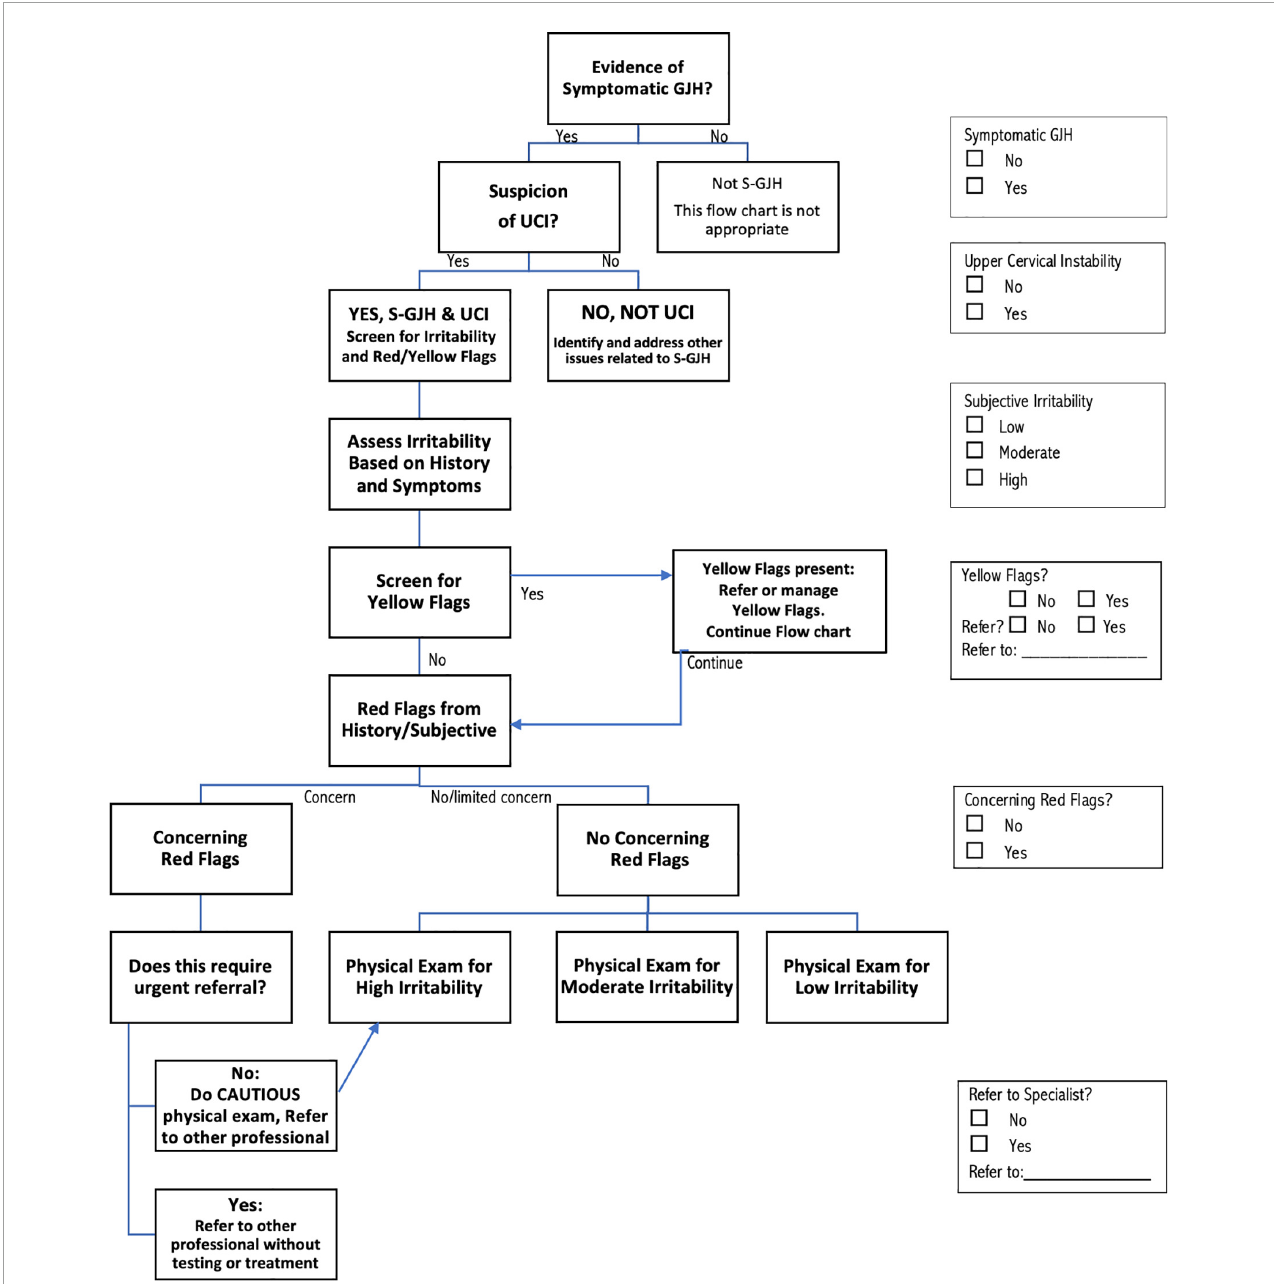
FIGURE1 Flow chart describing the screening process for determining that patients have upper cervical instability (UCI) associated with symptomatic generalized joint hypermobility (S–GJH), irritability and identifying yellow flags and red flags. The screening steps can be implemented in any order, using the check boxes on the right to keep track of decisions made at each step. See text and tables for more detailed discussion of each step in the process.